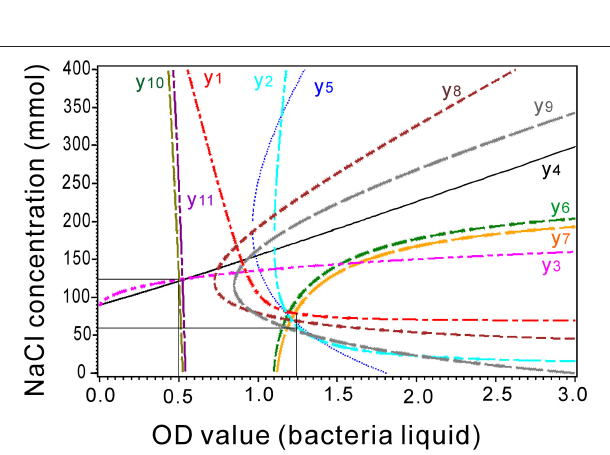
FIGURE 7 | Combination of the ridge lines for the response surface models associated with the equivalent effects of NaCl concentration and bacterial liquid. y 1 , Proline content; y 2 , soluble sugar content; y 3 , chlorophyll content; y 4 , root length; y 5 , shoot length; y 6 , total root length; y 7 , root surface; y 8 , fresh weight; y 9 , dry weight; y 10 , number of first-order lateral roots; and y 11 , number of root tips of the seedlings.